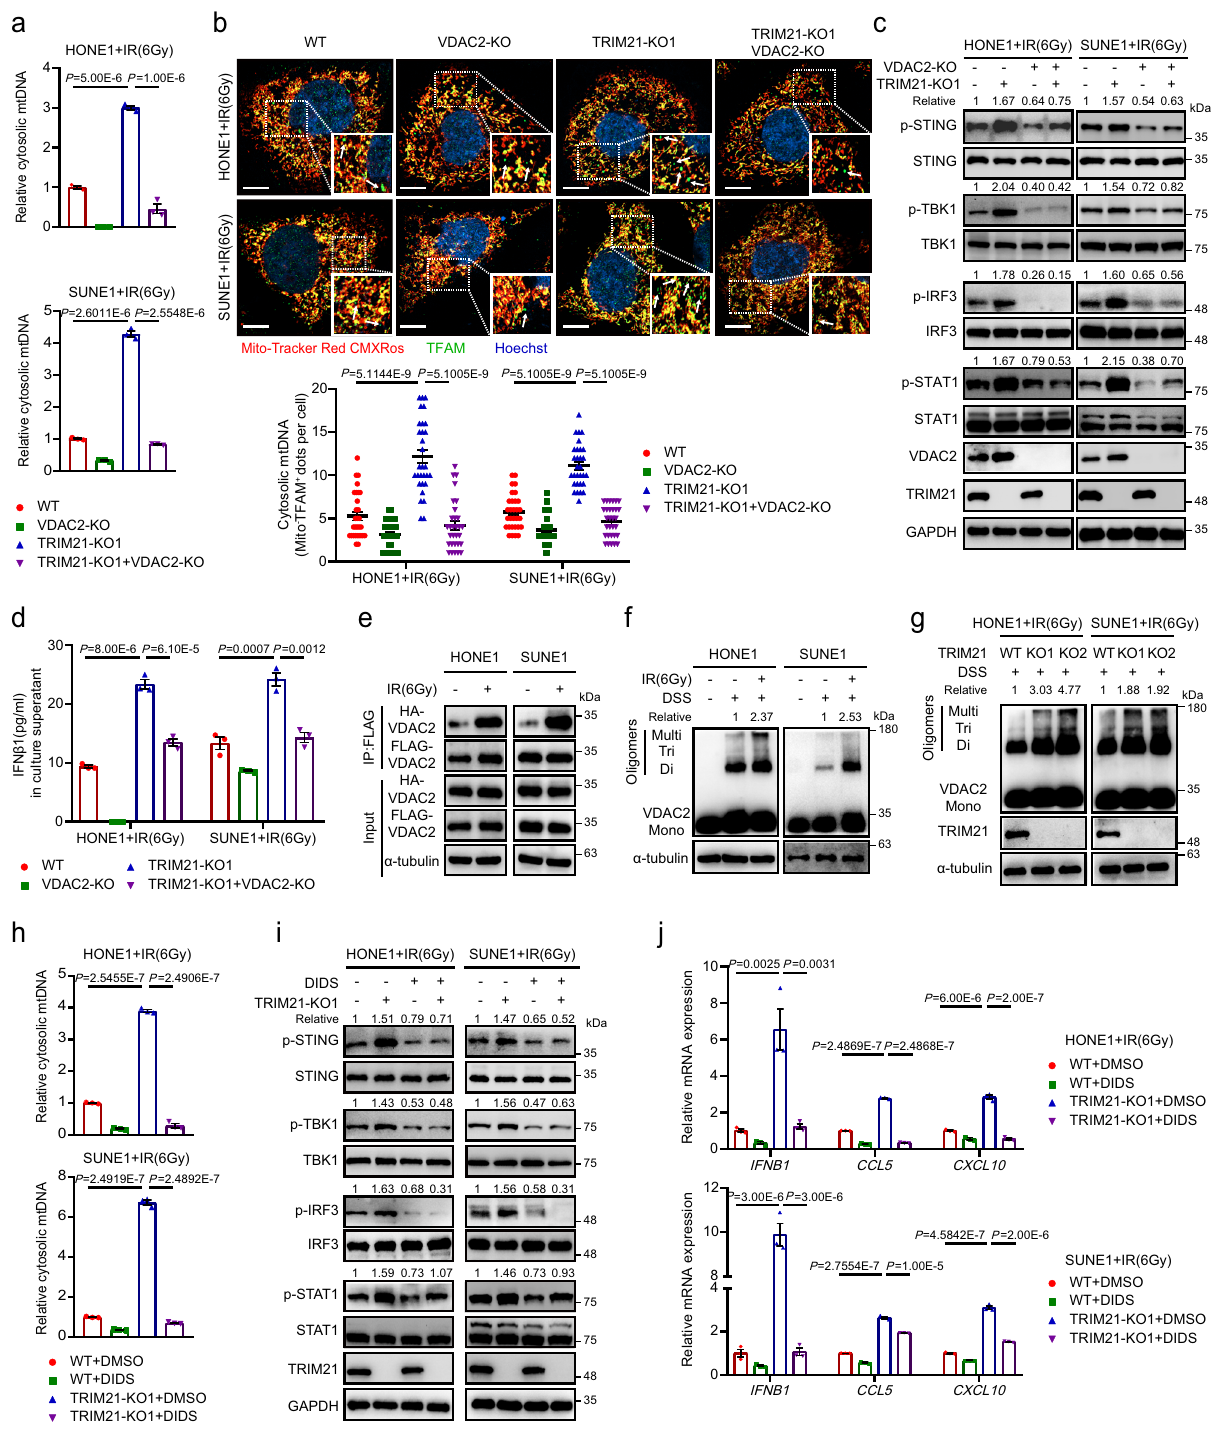
Fig. 4 | TRIM21 depletion facilitates VDAC2 oligomerization-mediated mtDNA release. a – d The indicated NPC cells were treated with IR. The relative MTATP8 abundance in the cytosolic fractions was assessed by qPCR ( a ). Cytosolic mtDNA accumulation was evaluated by quanti fi cation of cytoplasmic TFAM (indicated by thewhitearrows)24hafterIRtreatment.Representativeimages(scalebar,10 μ m) and quantitative results are shown ( n =30 cells per group) ( b ). The levels of total andphosphorylatedSTING,TBK1,IRF3andSTAT1( c )andtheIFN- β 1levelinculture